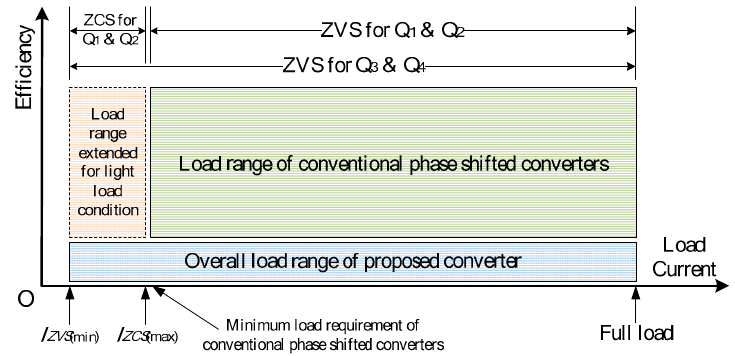
Figure 7. Diagram of Extended Load Range.